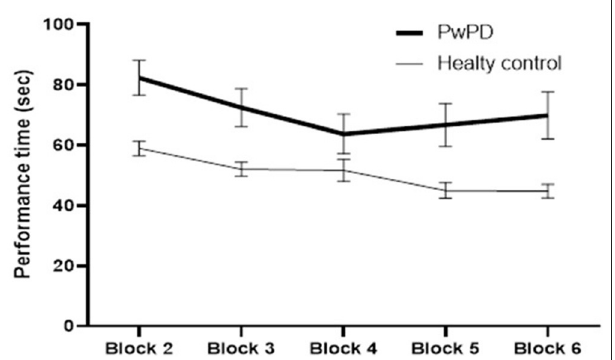
FIGURE 3 | Practice-related improvement in performance (recorded errors) across blocks in PwPD and healthy controls. Post-hoc analysis indicated significant difference between Block 6 and Block 2 in both groups. In healthy controls, significant differences were also found between (Block 2 and Block 3) and between (Block 3 and Block 4). In PwPD, significant differences were also found between (Block 4 and Block 5), between (Block 3 and Block 4), and between (Block 3 and Block 4).